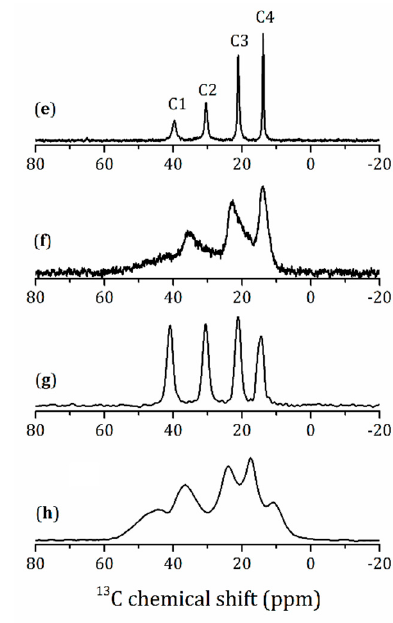
Figure 7. 13 C{ 1 H} CP NMR spectra of HLT 3 × MeNH 2 under MAS at ν rot = 14 kHz ( a ) and static ( b ) conditions in magnetic field 9.4 T. 13 C-NMR spectra of MeNH 2 HCl under MAS at ν rot = 5 kHz ( c ) and static ( d ) conditions in magnetic field 7 T. 13 C{ 1 H} CP NMR spectra of HLT 3 × BuNH 2 under MAS at ν rot = 14 kHz ( e ) and static ( f ) conditions in magnetic field 9.4 T. 13 C-NMR spectra of BuNH 2 HCl under MAS at ν rot = 5 kHz ( g ) and static ( h ) conditions in magnetic field 7 T.